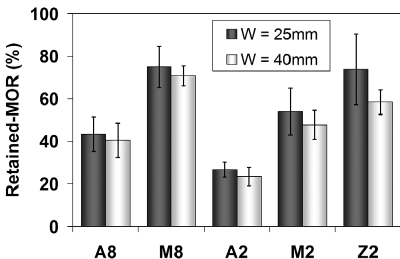
Figure 6. Retained-MOR of the refractory castables after thermal shock of ΔT = 800 °C for small and large